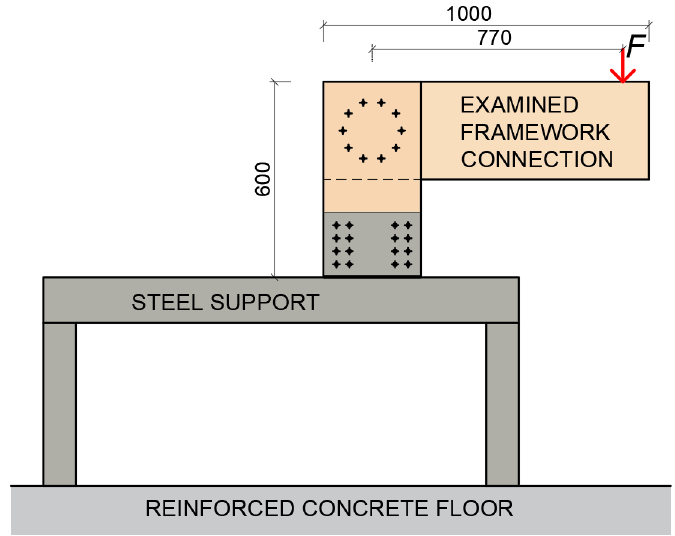
Figure 2. Schematic illustration of the experiment.